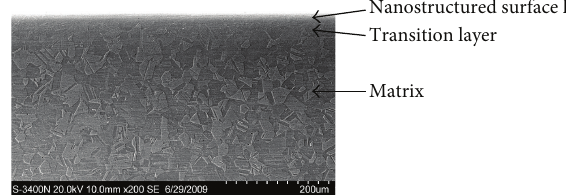
Figure 1: SEM image of the sample after SNC treatment with